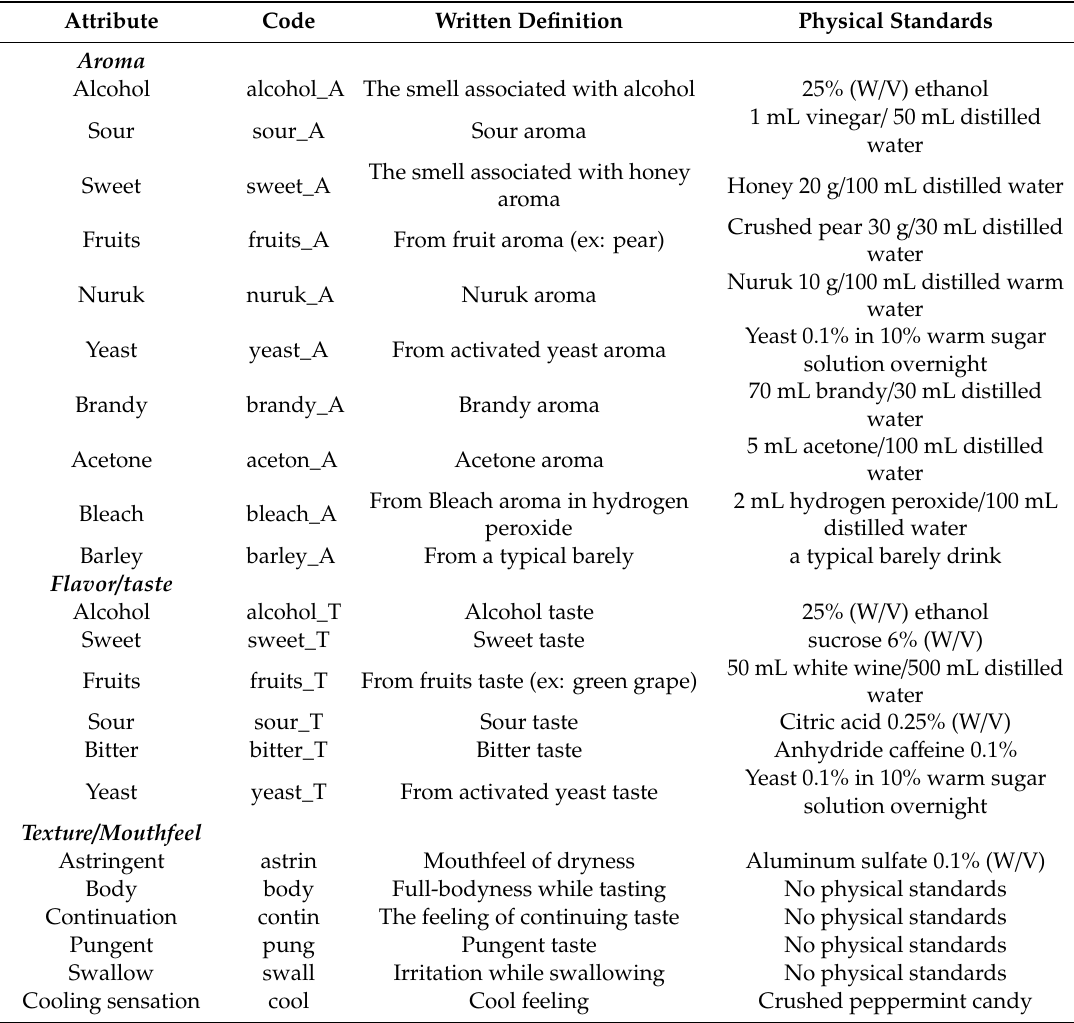
Table 2. Sensory code, attributes, definitions, and physical standards of distilled